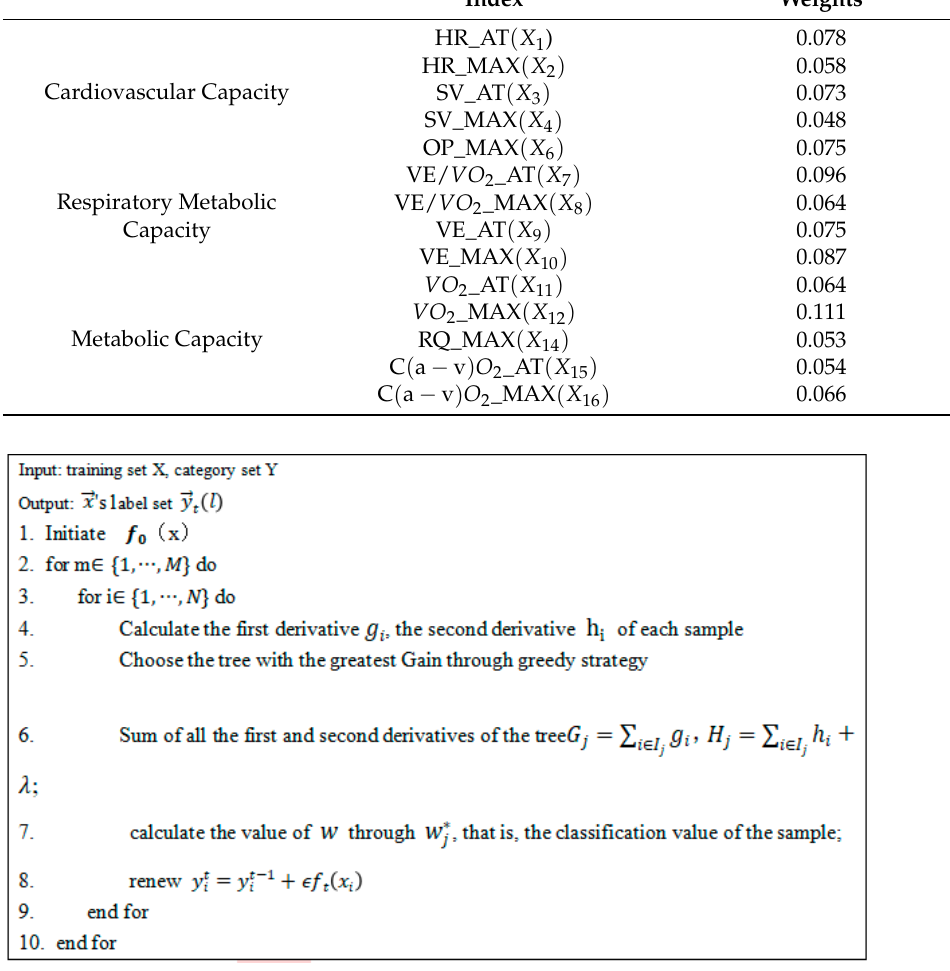
Figure 3. Pseudocodes of the XGBOOST algorithm.